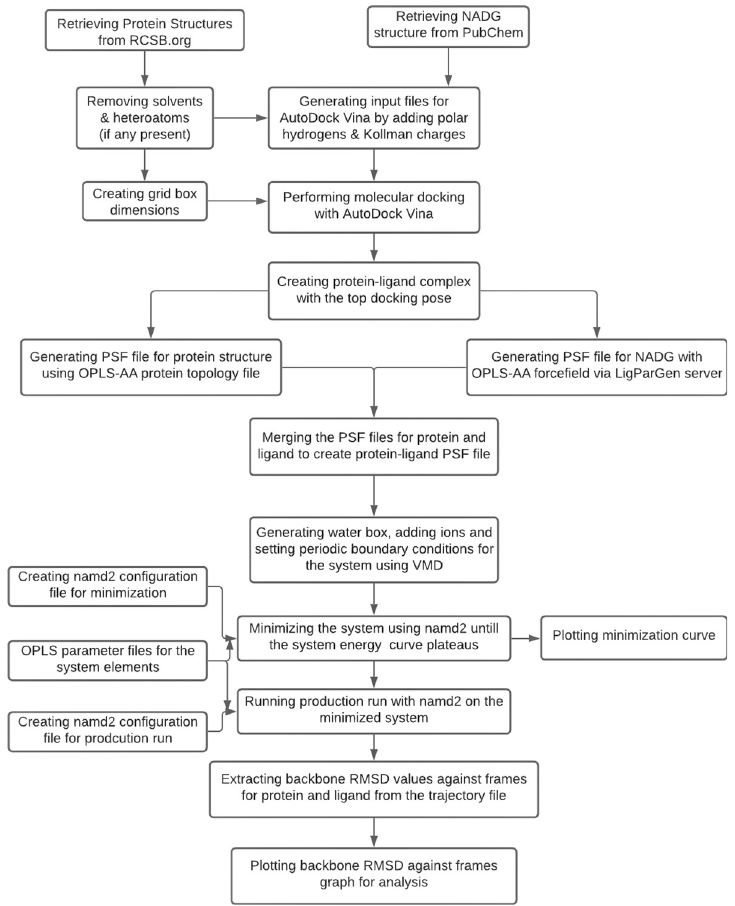
Fig 1. General workflow applied for all the proteins analyzed in the